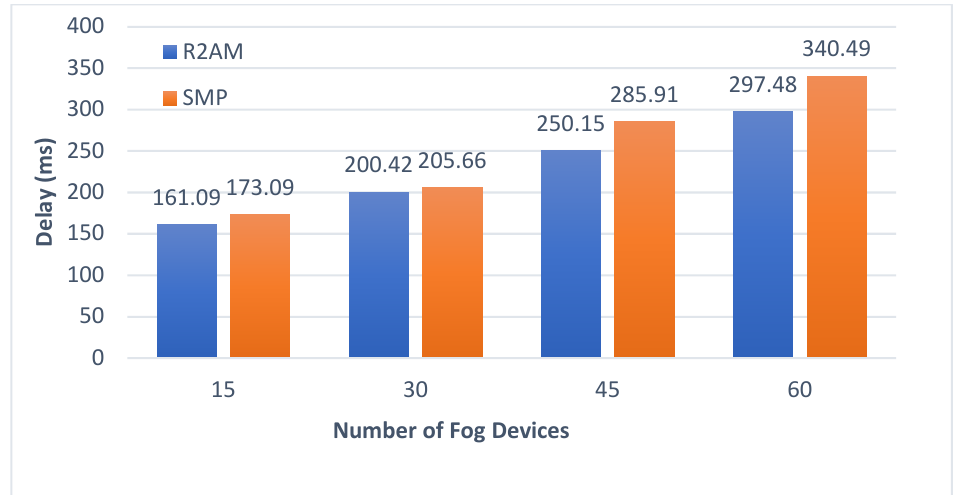
Figure 2. Latency comparison of proposed and existing strategies .